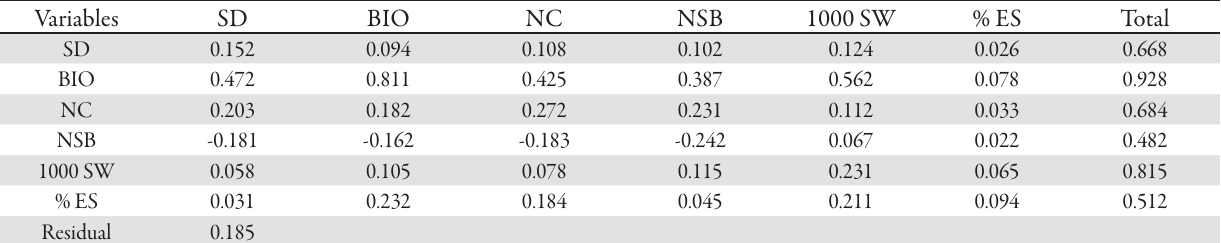
Tab. 4. Direct and indirect effects of black seed characters on seed yield under water deficiency conditions